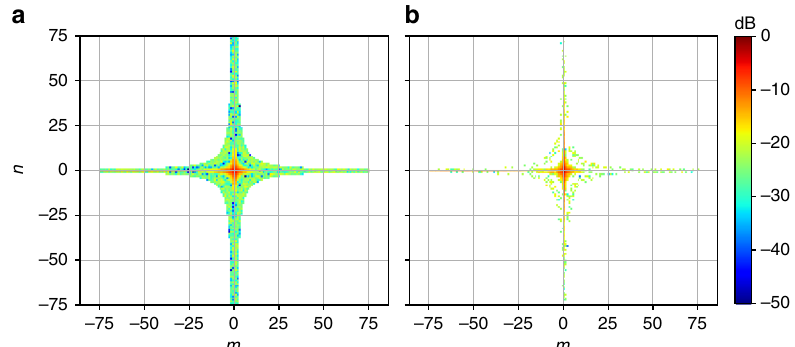
Fig. 6 Density plots. The density plot of the input layer weights of the NN model at a initial N t = 1929 and b N t = 615 triplets after iterative trimming ( κ = − 22 dB). Colorbar shows the magnitude of the weights Fig. 4 requires 2 N t × 2 + 2 × 10 + 10 × 2 = 4 N t + 40 real multi- plications because of three cross-layer tensor interaction. Note